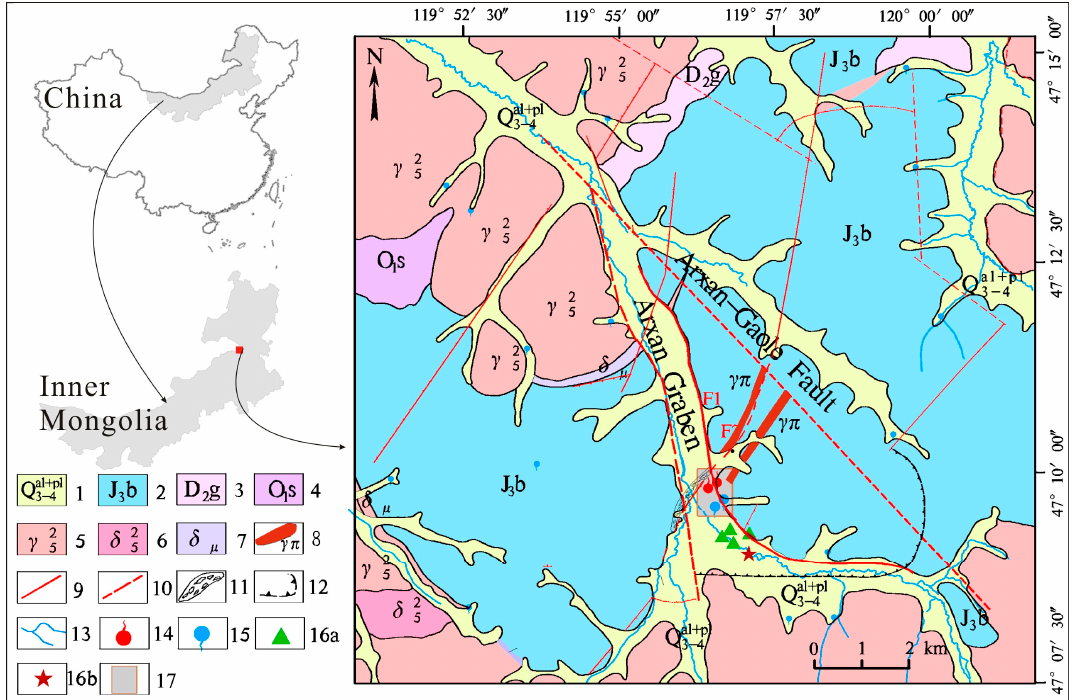
Figure 1. Map of the study area: 1, gravel, sand and clay (Quaternary); 2, tuff and breccia (Jurassic); 3, conglomerate and killas (Devonian); 4, glutenite and argillaceous siltstone (Ordovician); 5, granite (Yanshanian); 6, quartz diorite (Yanshanian); 7, dioritic porphyrite (Yanshanian); 8, granite dyke; 9, fault; 10, inferred fault; 11, volcanic conduit; 12, caldera; 13, rivers; 14, thermal springs; 15, mineral springs; 16, sampling points of the shallow (a) and deep (b) groundwater; and 17, study area.